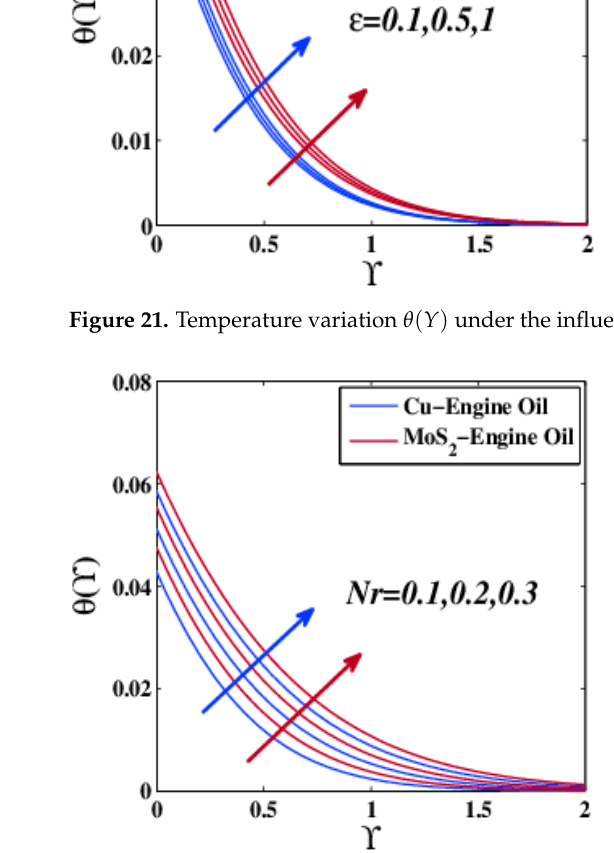
Figure 22. Temperature variation θ ( Y ) under the influence of Nr .